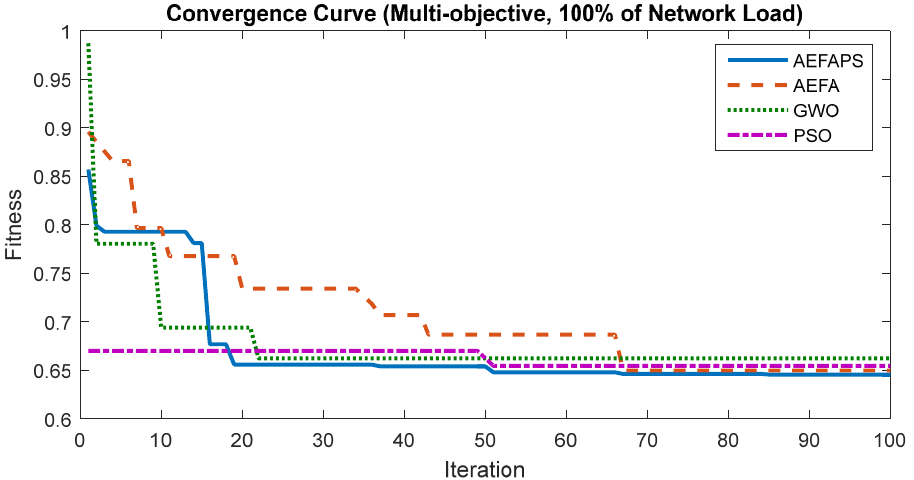
Figure 5. Convergence curve of different methods in a many-criteria reconfiguration solution for a 33-bus network (100% of network load).